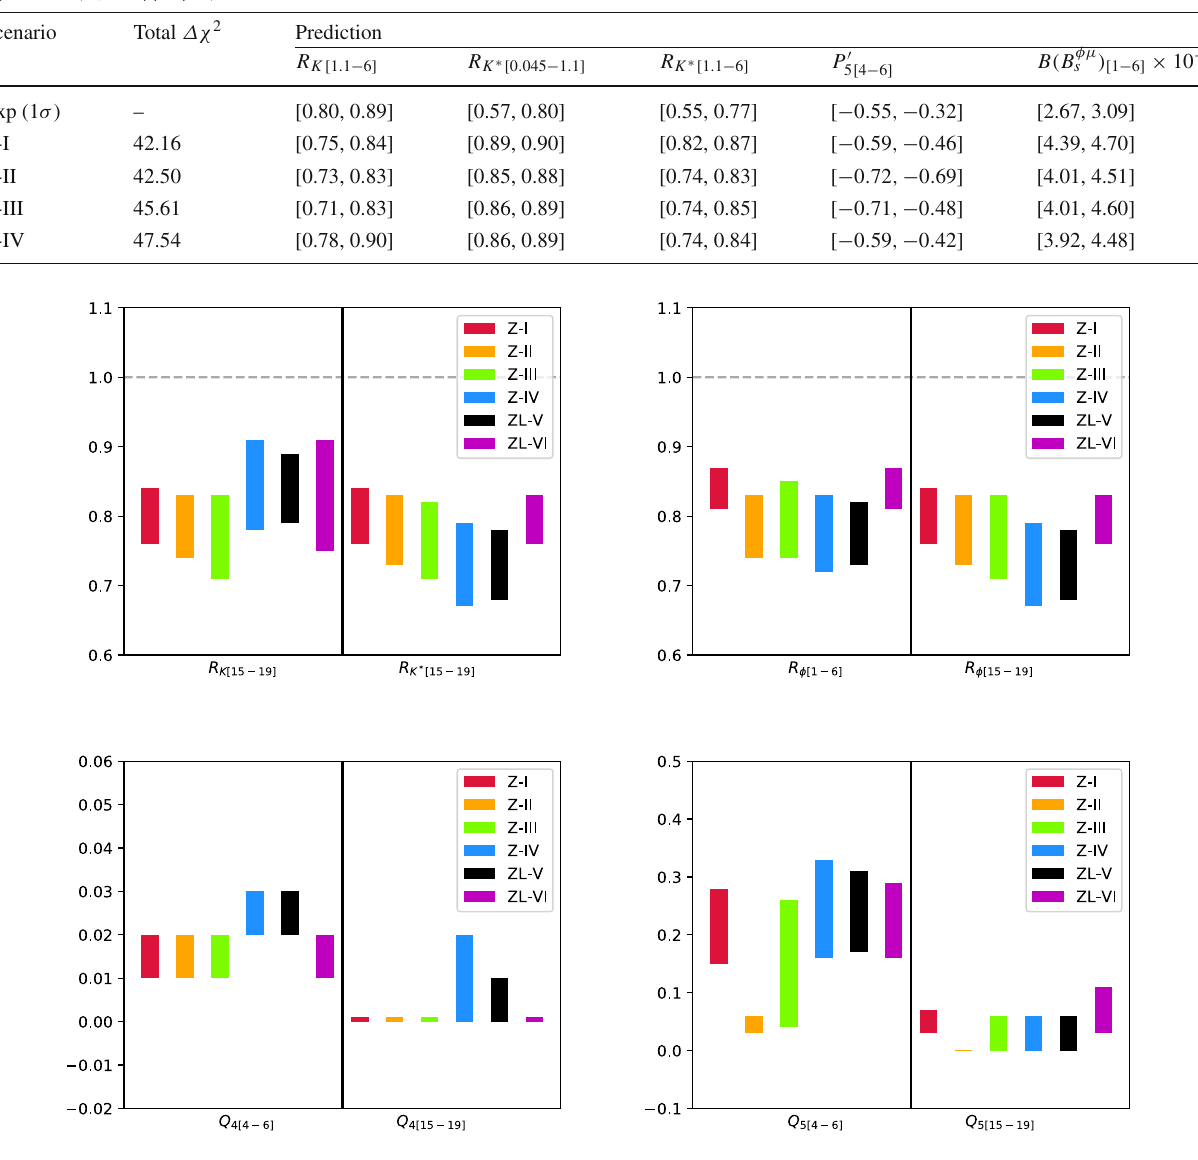
Fig. 3 Prediction (1 σ range) of additional LFUV observables in heavy and light Z (cid:4)